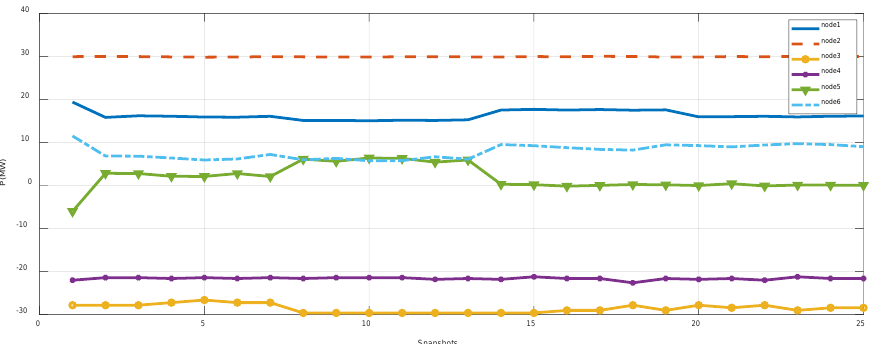
Figure 8. Active powers in operating states with minimum flexibility.